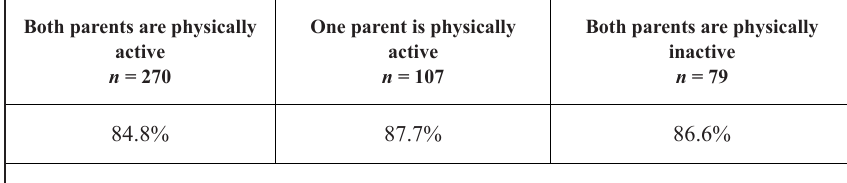
Table 1. Percentage distribution